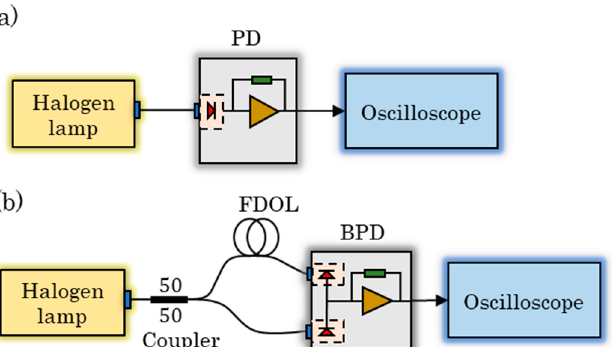
Figure 3. The experimental setup to measure the background noise: ( a ) based on SPM and ( b ) based on BDM.